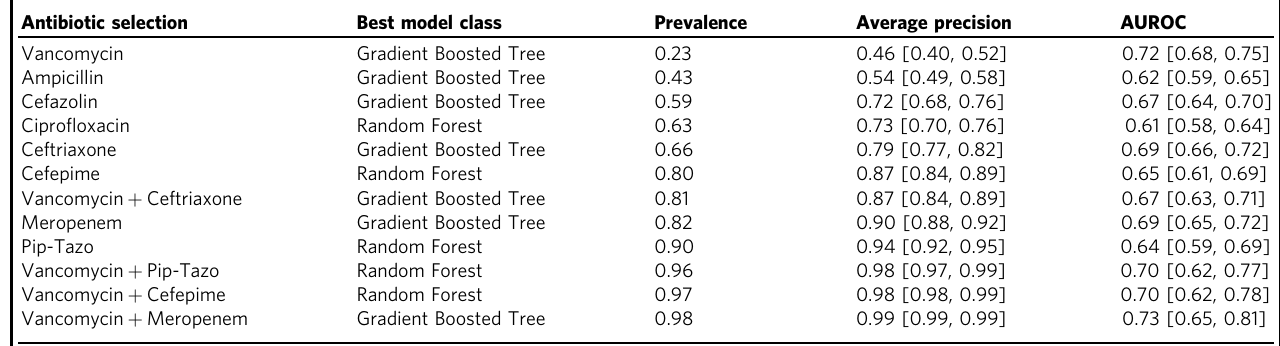
Table 3 Antibiotic susceptibility classi fi er performance. Antibiotic